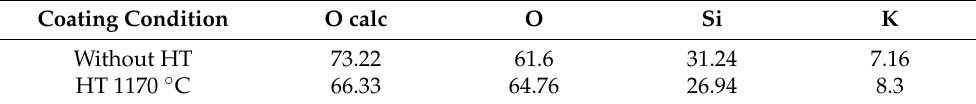
Table 4. Results of the XPS elemental analysis of the coating material, normalized to carbon (at.%). Coating